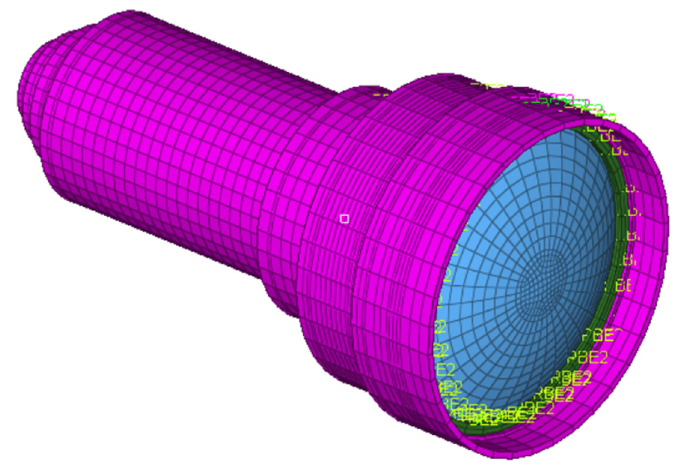
Figure 5. FEA model of the optical system.